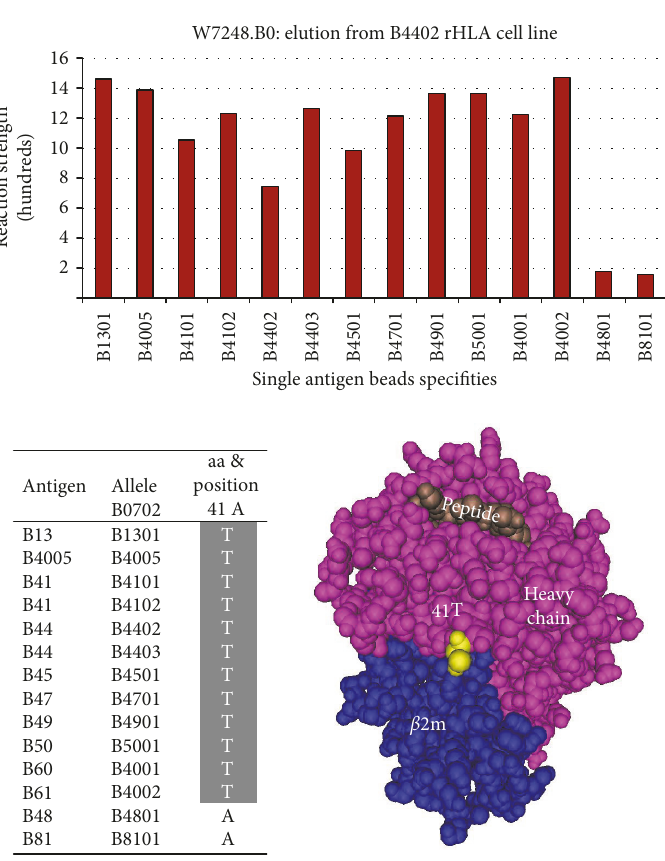
Figure 6: Epitope 21 shared by the B-locus antigens B13, B4005, B41, B44, B45, B47, B49, B50, B60, and B61 and de fi ned by 41T.